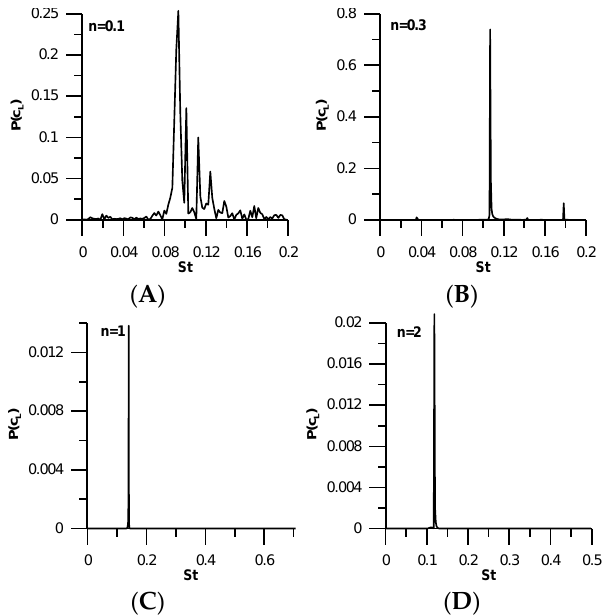
Figure 10. Power spectra of the lift coefficient for Re = 100 and different values of the power-law index: